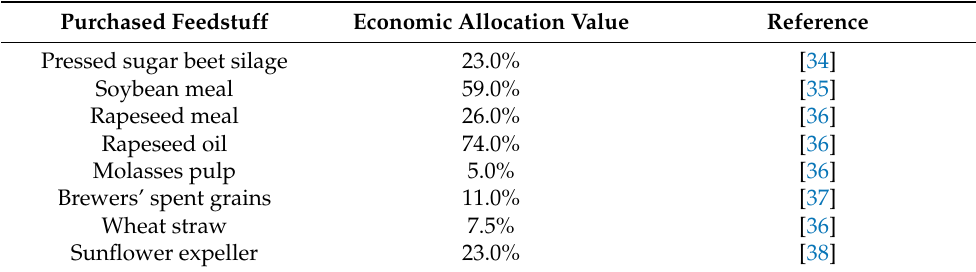
Table 3. Allocation factors used for emission